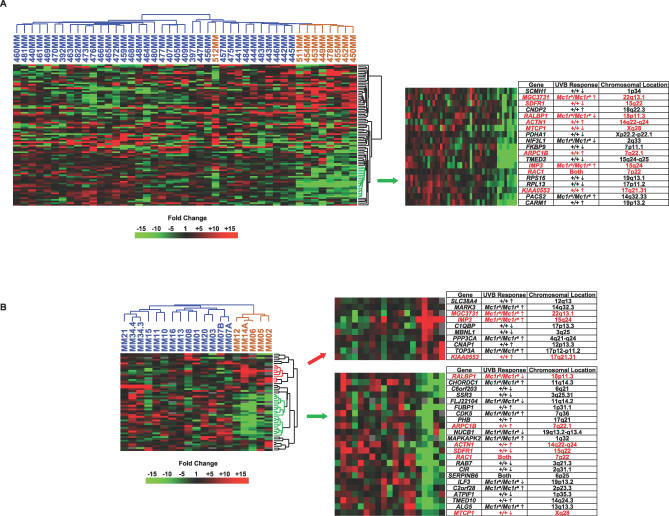
Unsupervised Hierarchical Clustering of Mc1r-Dependent UVB-Responsive Genes in Human Melanoma SamplesOrthologous human gene expression data, derived from 120 mouse genes that were identified as Mc1r-dependent and UVB-responsive in the basal epidermis of P2.5 mice, were clustered in (A) a primary melanoma data set [55], here consisting of 86 genes and 45 samples, and (B) a melanoma metastases data set [56], here consisting of 53 genes and 19 samples. Melanoma subclusters correspond to the original subtypes, TNM stage I-II (blue) versus III-IV (orange) in (A), first identified by Talantov et al. [55], and growth phase type I radial (orange) versus type II vertical (blue) in (B), first identified by Haqq et al. [56]. Genes driving the observed melanoma clustering patterns are displayed to the right of each large cluster, along with their corresponding UVB response (↑, induction; ↓, repression; and Both, regulation in both Mc1r+/Mc1r+ and Mc1re/Mc1re) in the Mc1r+/Mc1r+ or Mc1re/Mc1re basal epidermis, as well as their chromosomal location. Genes highlighted in red are common to both primary and metastatic melanoma gene clusters. Red, green, and black indicate induction, repression, and no change, respectively, relative to the centered median. Gray represents missing data. The ratio fold-change is indicated by a scale bar.